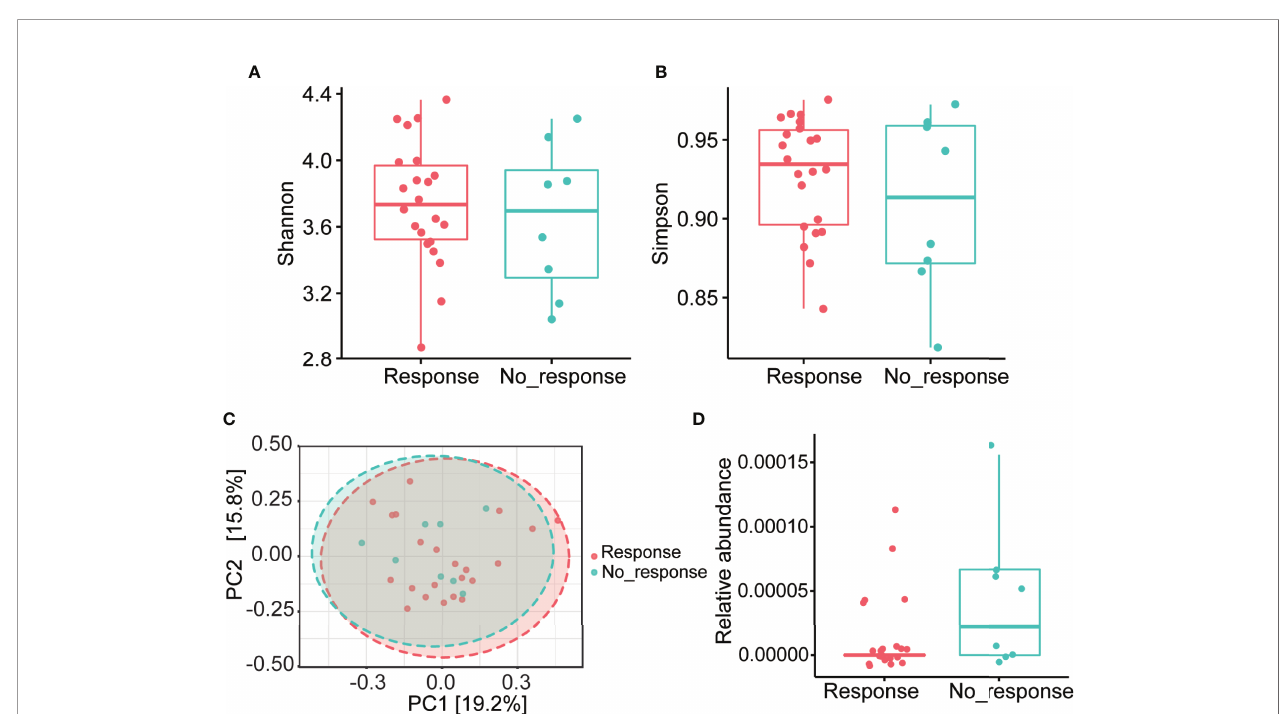
FIGURE 4 | Gut microbial community structure of AS patients before treatment with different responses to Adalimumab. (A, B) a -diversity; (C) PCoA based on unweighted UniFrac distance. (D) Relative abundance of Comamonas in response and no_response subgroups. AS, ankylosing spondylitis; PCoA, principal coordinates